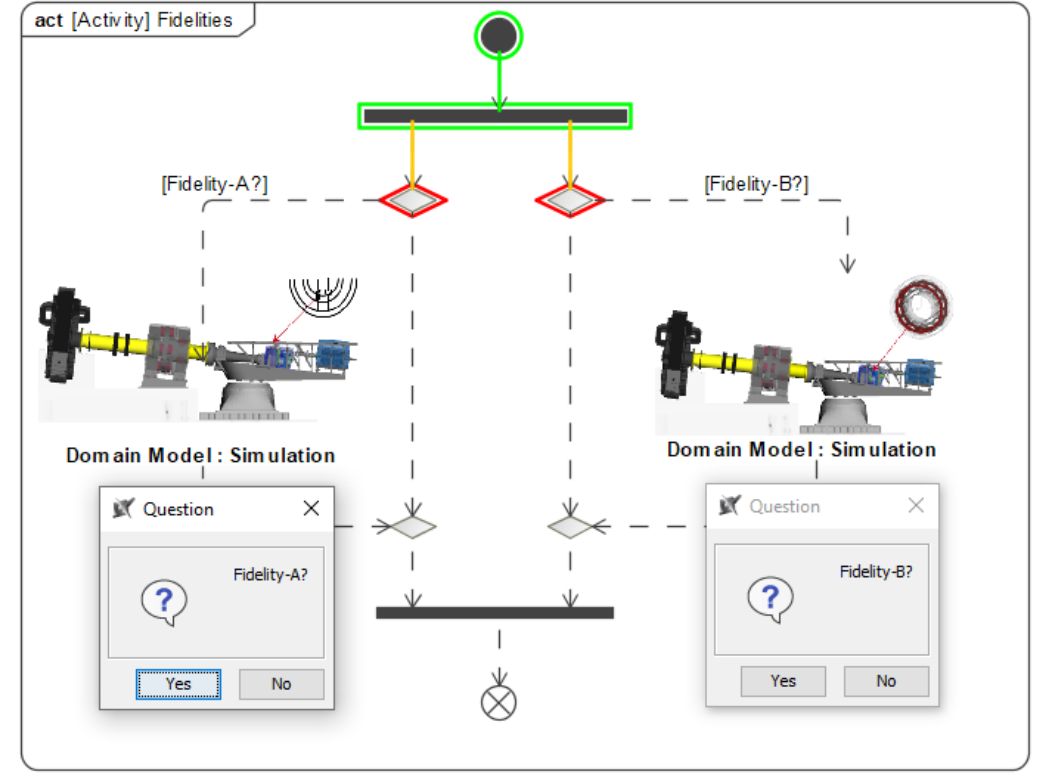
Figure 11. Determination of the fidelity of the domain model manually based on decision nodes.